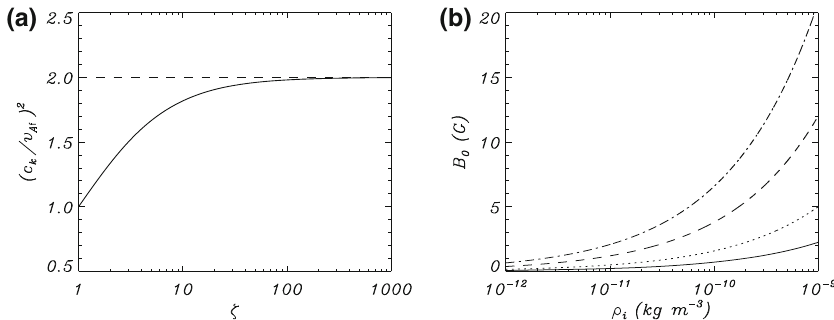
/v 2 Fig. 84 a Ratio c 2 k Af (solid line) as a function of the density contrast, the value of the ratio c 2 k /v 2 Af for ζ → ∞ . b Magnetic field strength as a function of the internal density, ρ p , corresponding to four selected threads. Image reproduced with permission from Lin et al. (2009), copyright by